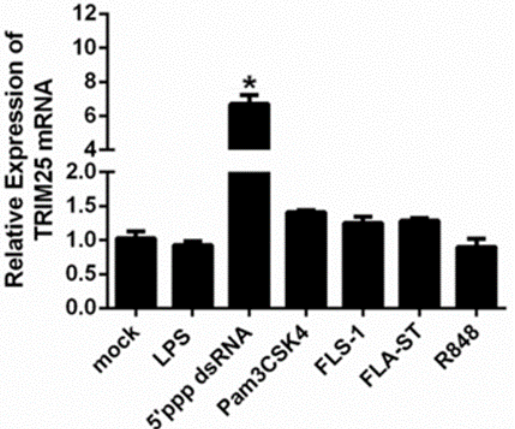
Figure 2. The expression of duTRIM25 was analyzed in DEFs after different stimulations. LPS (lipopolysaccharides, the main components of the cell wall of Gram-negative bacteria), 5′ ppp dsRNA (double-stranded RNA, which is a synthetic ligand for RIG-I), Pam3CSK4 (triacylated lipopeptide, which is the acylated amino terminus that mimics bacterial LPS), FLS-1 (Pam2CGDPKHPKSF, which is a synthetic lipoprotein derived from Mycoplasma salivarium ), FLA-ST (flagellin from Salmonella typhimurium , the principal component of the flagella present on many bacteria), R848 (resiquimod, which is an imidazoquinoline compound with potent antiviral activity). Asterisks indicate significant differences determined by a t -test between mock and virus- or bacteria-mimicking stimulus treatments, p < 0.05. Each bar represents the mean ± SE ( n =